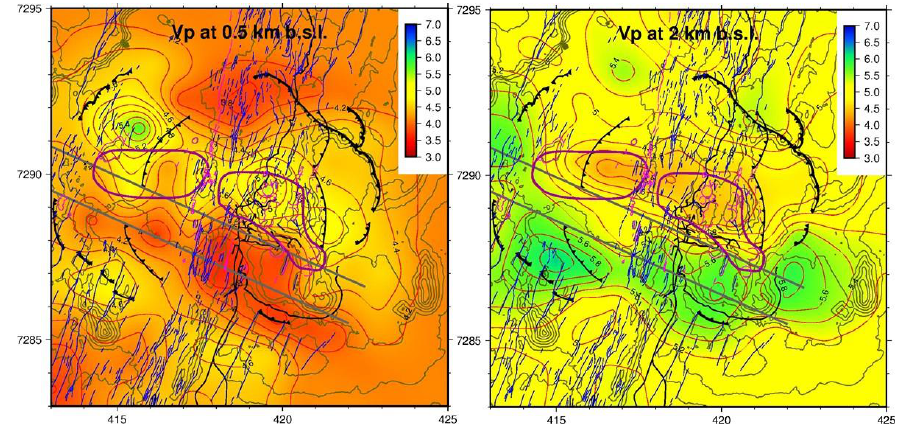
Figure 12. P-wave velocity (km/s) at 0.5 km bl.sl. (left) and at 2 km bl.sl. (right) according to recent seismic tomography (reproduced from [34]). Black hatched lines show the two calderas, grey lines mark the low-density transverse structure, blue lines show faults and fissures and the purple lines mark the S-wave shadows. Coordinates are UTM WGS84 zone 28 in km.